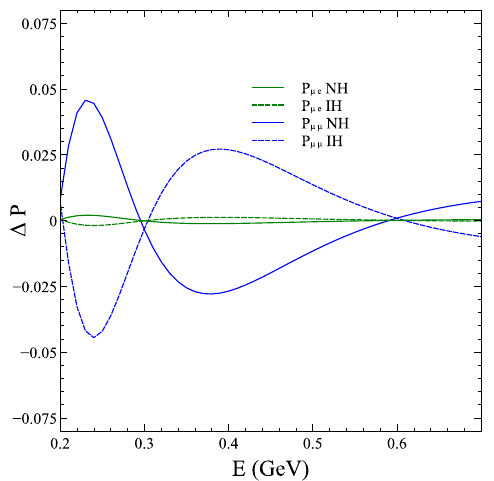
Figure 1 . Difference in probability as a function of energy. The plot is shown for L = 295 km and without matter effect. The black lines show ∆ P µµ while the green lines show ∆ P µe . The solid lines are for NH while the dashed lines are for